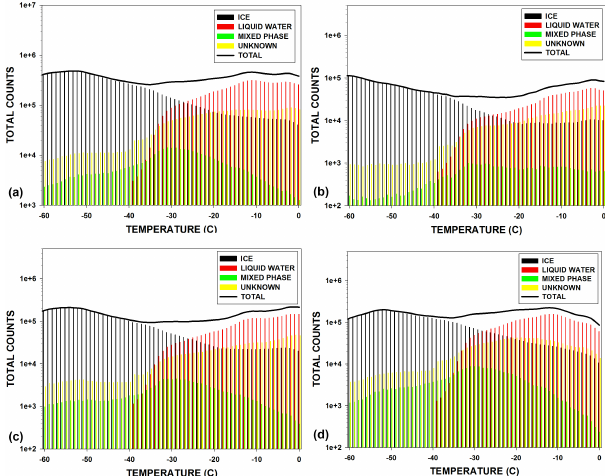
Figure 2. Corresponding with Fig. 1a–d, total counts per 1 ◦ C in- terval and for each CALIOP Level-2-retrieved cloud phase and their